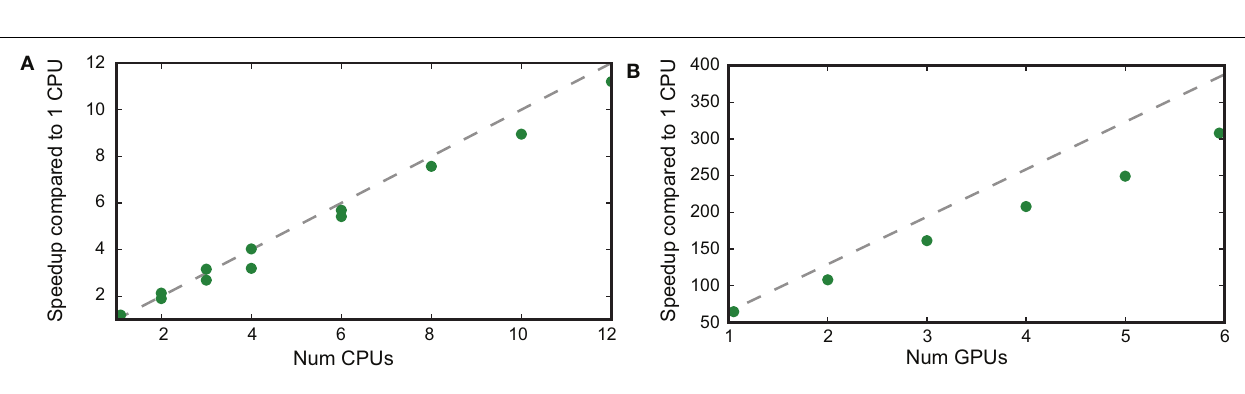
FIGURE 6 | Speedup with multiple CPUs and GPUs. A fi tting task was performed over 1-s-long electrophysiological data. (A) Speedup in the simulation of 10 iterations with 400,000 particles as a function of the number of cores, relative to the performance of a single CPU. We used different cluster confi gurations using 1 − 12 cores spread among one up to three different